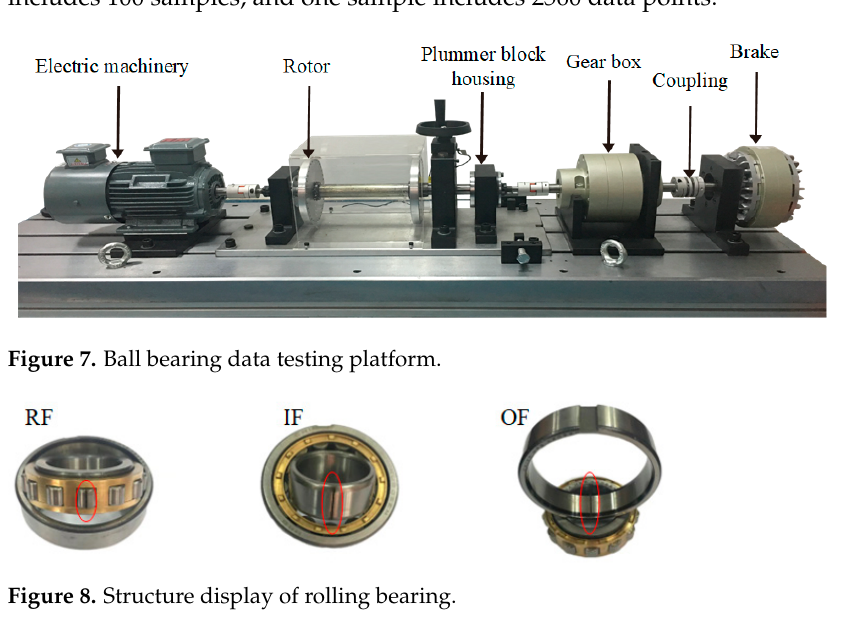
Figure 6. Comparison of the confusion matrixes obtained by different approaches. ( a ) Confusion matrix in case A. ( b ) Confusion matrix in case B.